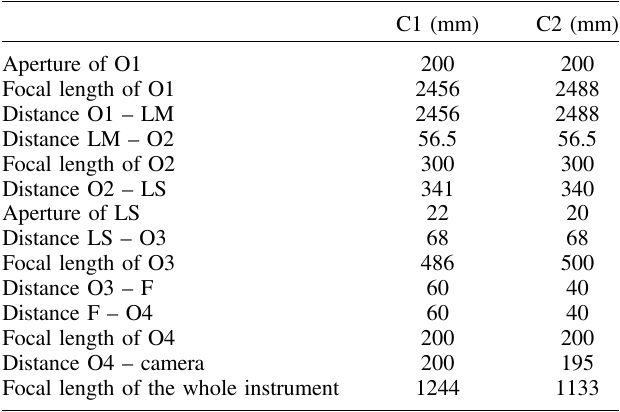
Fig. 6. Detailed view of the C1 back end in its hexagonal structure. From right to left one can see the Lyon stop hold by the red panel, O3, the H a fi lter, O4, and at the far left the CCD camera. Table 3. Optical speci fi cations of C1 and